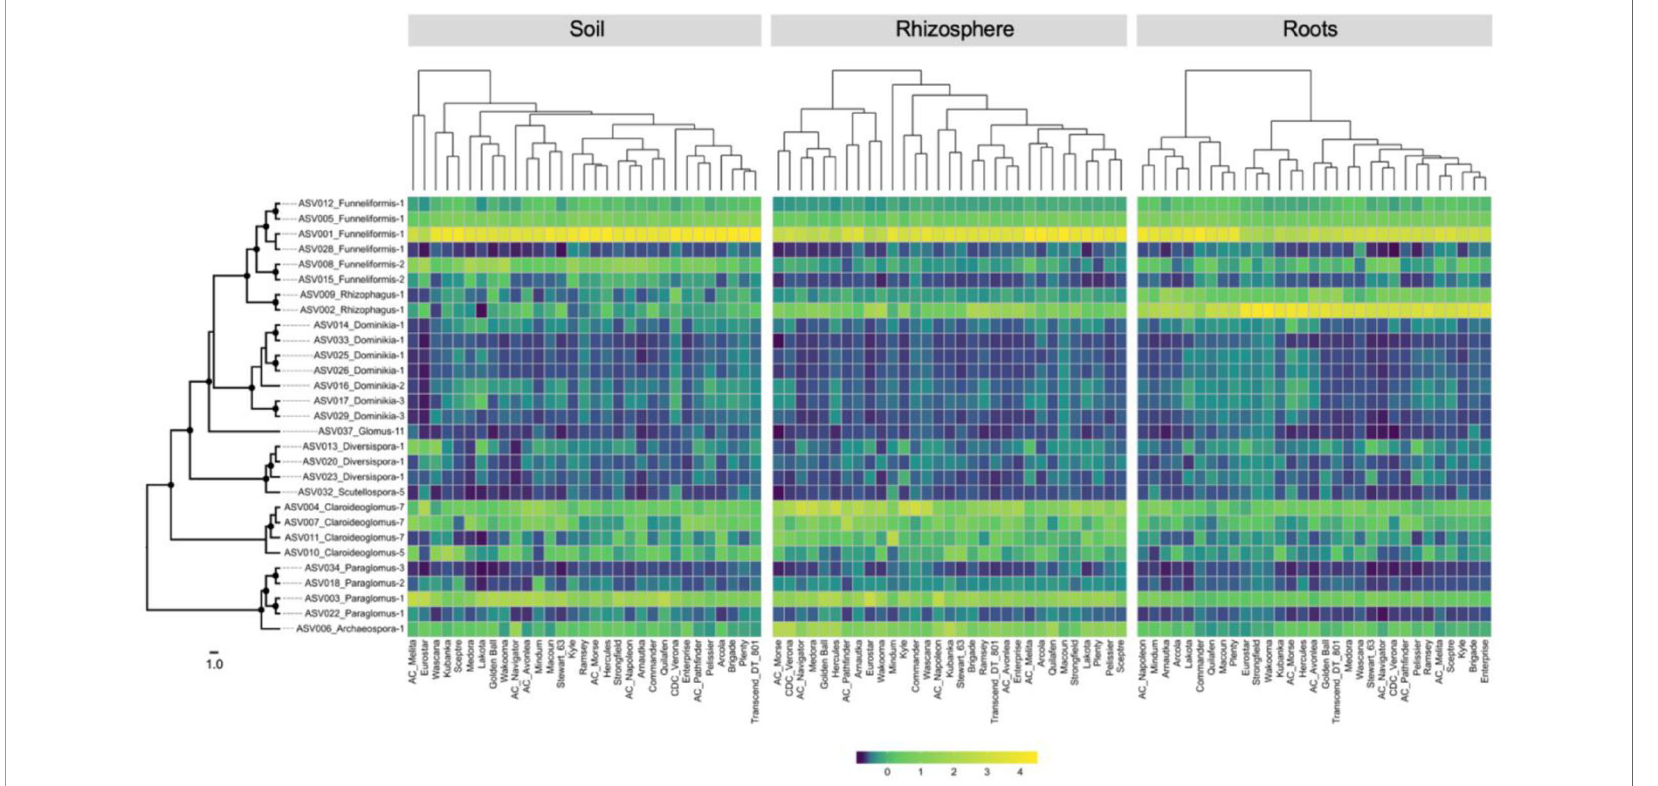
FIGURE 4 | Heatmaps showing the relative abundance of each of the 29-core amplicon sequence variants recorded in soil, rhizosphere, and root compartments for the fi ve landraces and 26 durum wheat cultivars. Left: RAxML phylogeny of 29 core ASVs, black circles on the nodes represent bootstrap values > 70. The scale represents the branch length corresponding to expected substitutions per site. Top: cladogram showing the relationships between each cultivar based on the distance matrix calculated on ASV relative